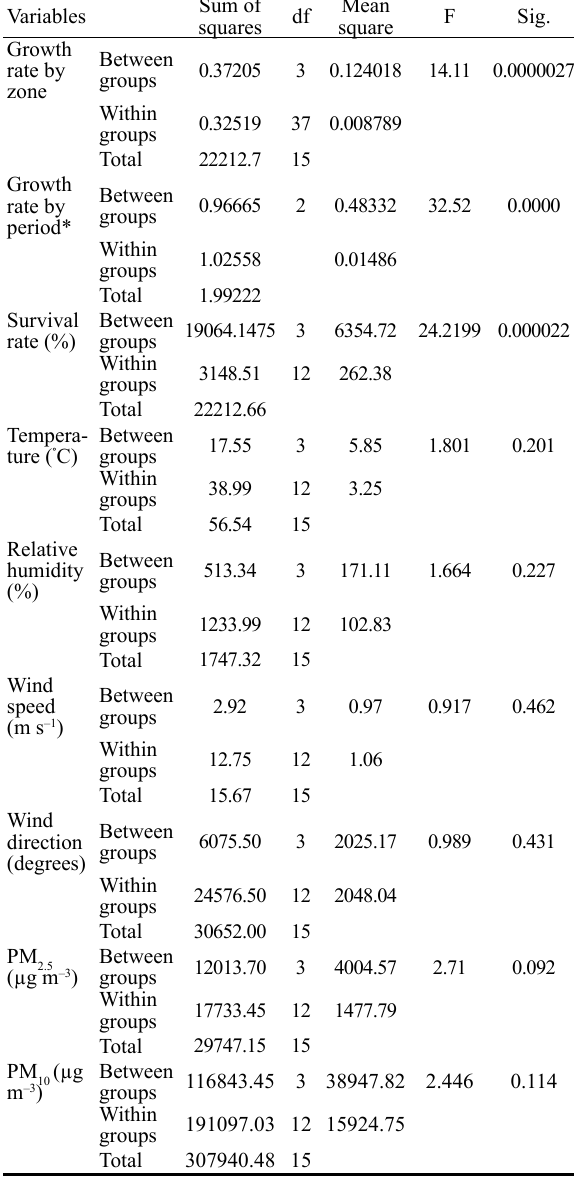
Table 2. – One-way analysis of variance of the selected environ- mental